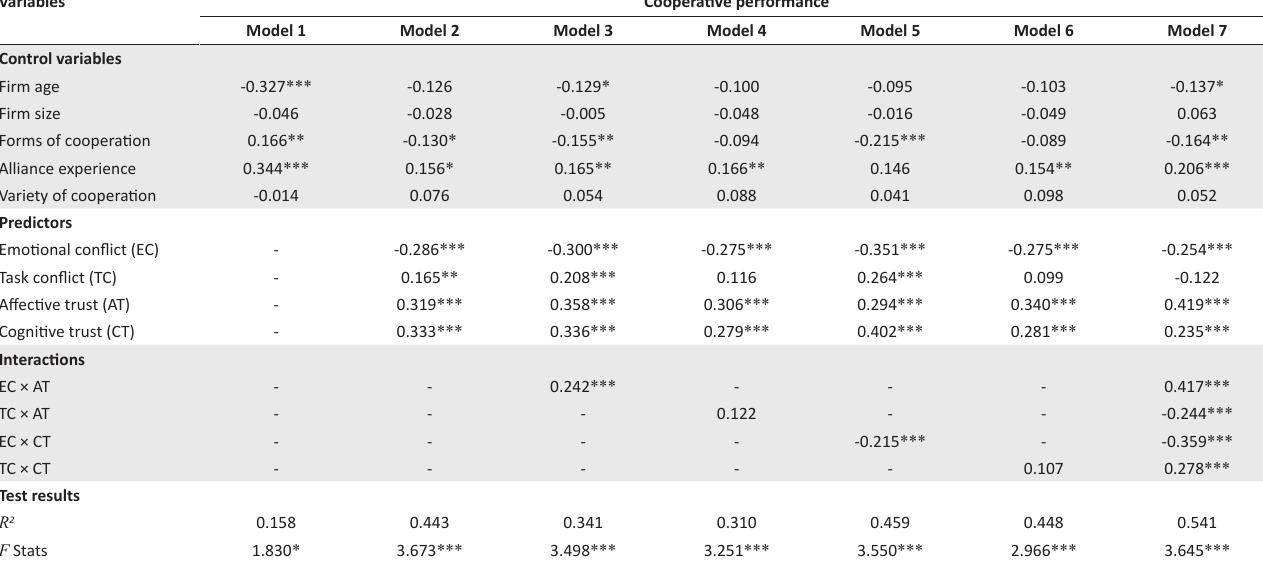
TABLE 3: Results of regression analysis.